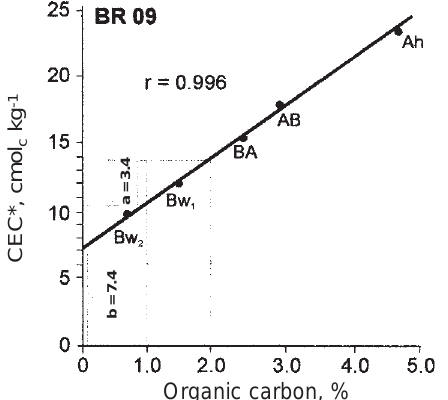
Figure 4. Relation between CEC of the soils and its contributors clay and organic carbon of profile BR 09 (based on procedures of Bennema, 1966 and Bennema & Camargo, 1979). * Units of both abcissa and ordinate were converted to 100% clay basis, e.g., for each horizon direct results of % C and CEC soil multiplied by 100/%